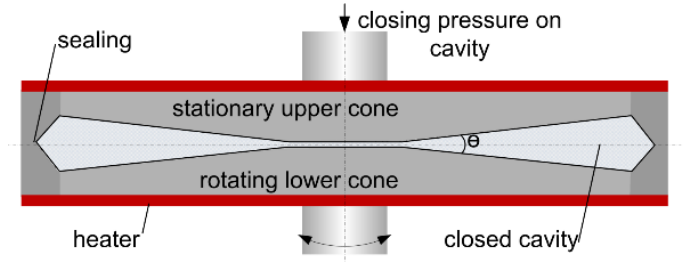
Figure 2. Schematic illustration of the closed cavity rheometer (CCR) used for rheological meas-